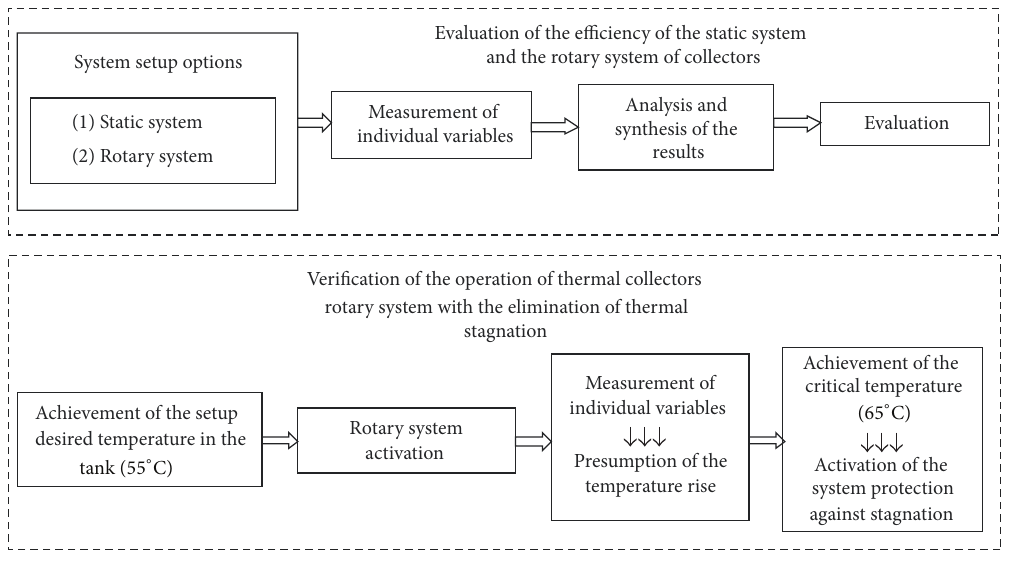
Figure 5: Flow diagram of the experimental measurements.